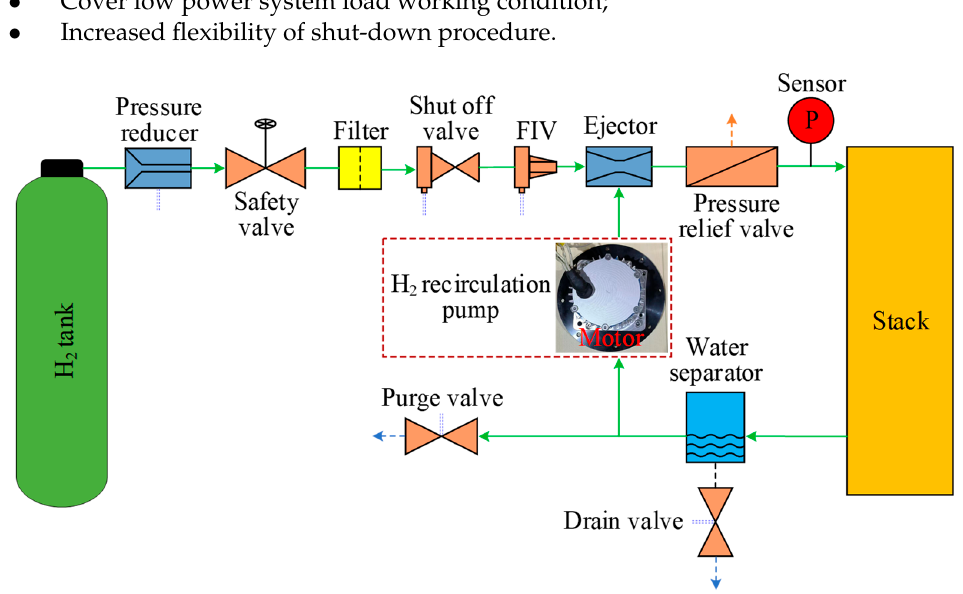
Figure 1. Hydrogen